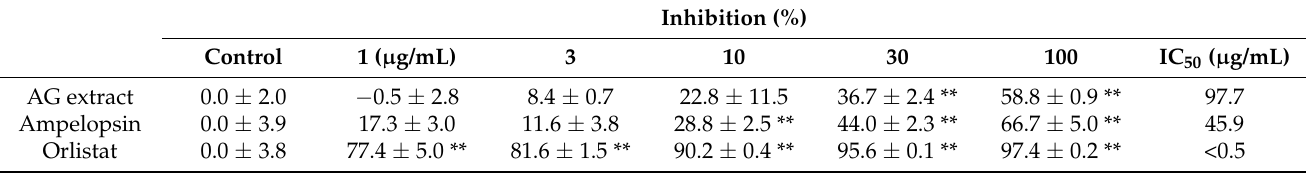
Table 5. Inhibition of pancreatic lipase activity by AG extract and